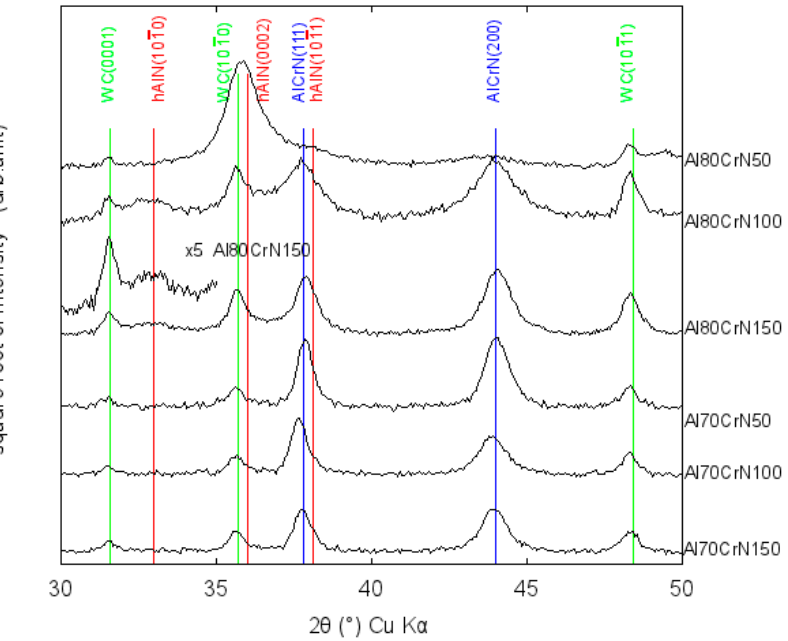
Figure 2. XRD scans of all variants using grazing incidence angle diffracton at α = 1° with reference peak positions (taken from ICDD files, see text).